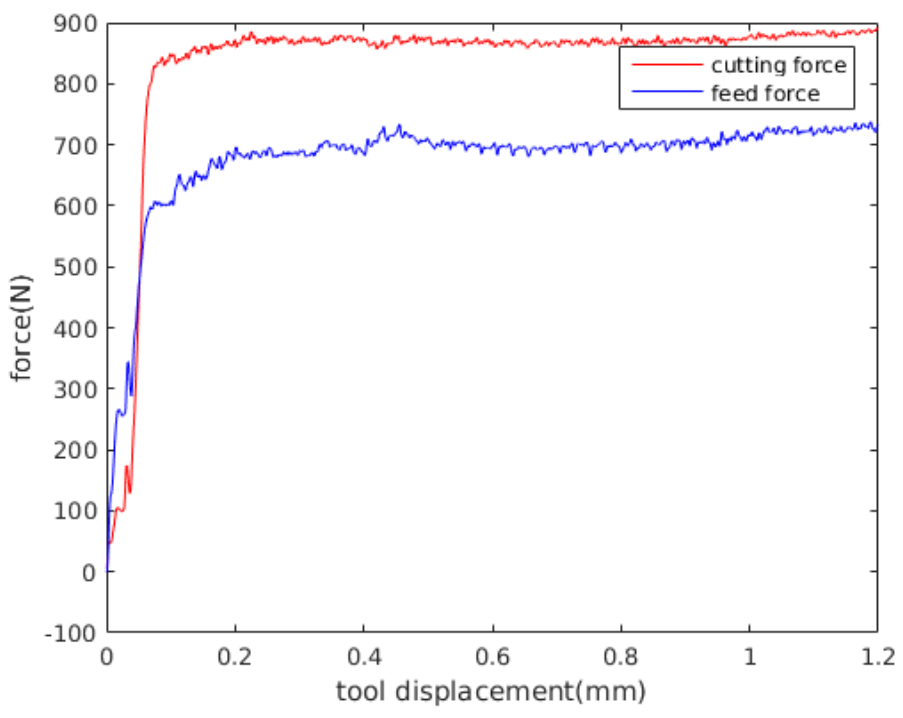
Figure 5. Experimental forces vs. tool displacement for experiment 4 (see Table